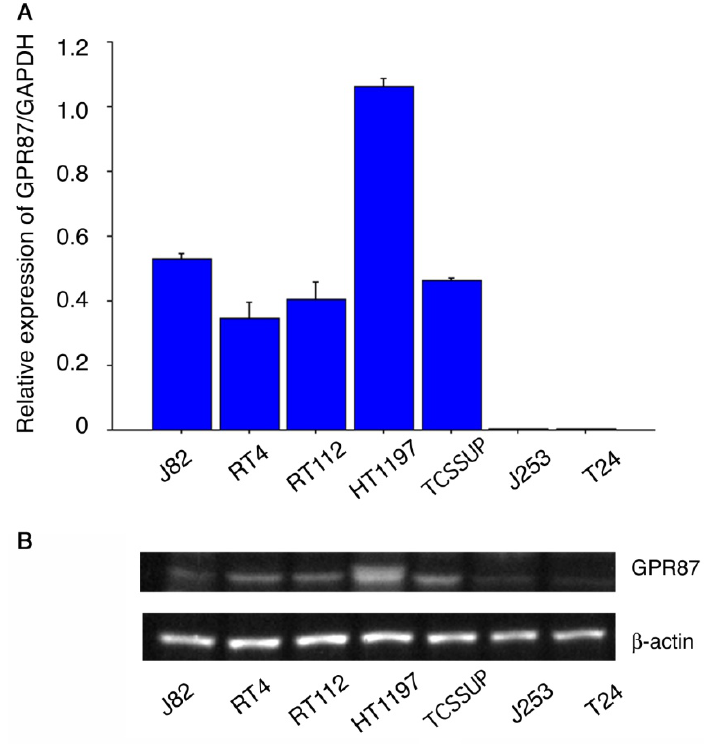
Figure 1. GPR87 expression in seven human bladder cancer cell lines. Relative expression levels of GPR87/GAPDH mRNA assessed by real-time RT-PCR ( A ) and GPR87 protein expression assessed by western blots ( B